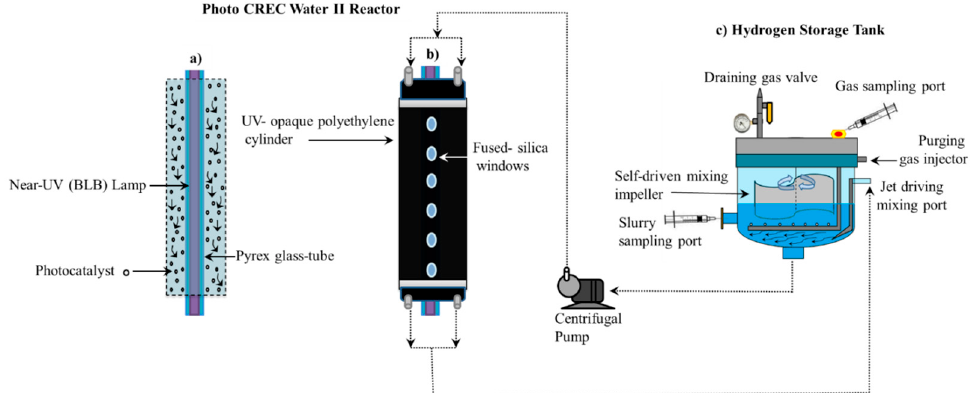
Figure 2. Schematic diagrams of the Photo-CREC Water II Reactor with a H 2 mixing/storage tank: ( a ) Longitudinal cross-section of the Photo-CREC Water II unit showing the downflow slurry circulation in the annular channel; ( b ) overall view of Photo-CREC Water II showing windows and recirculation pump and ( c ) hydrogen storage tank with its components. Adapted from [10]. Table 1. Absorbed photon fluxes for the various photocatalysts of the present study. Pi , represents the incident radiation whereas P t , is the transmitted radiation and P a is the absorbed radiation.